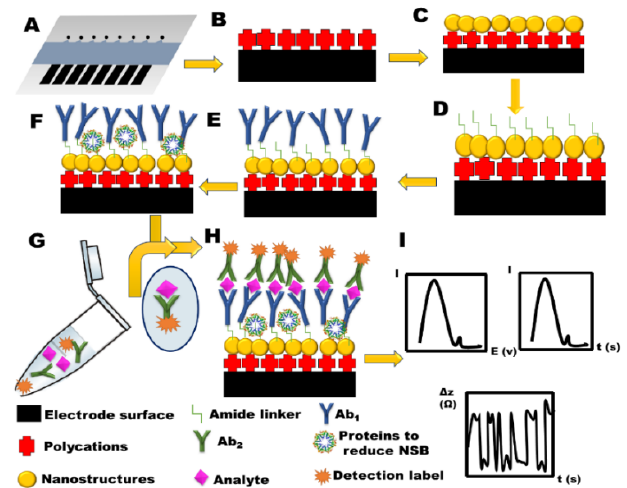
Figure 2. Different Ab 1 immobilization strategies on SPCE. Reprinted with permission from [47], copyright 2019 The Royal Society of Chemistry.